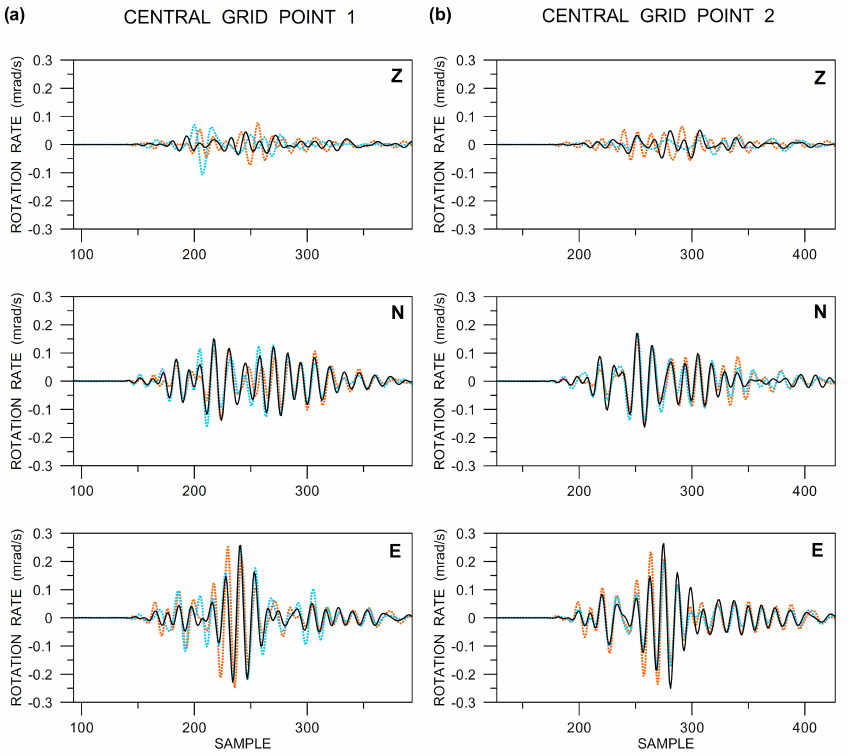
Figure 16. Comparison of the ADR (dotted orange), Rotaphone (solid black), and R-1 rotation rate components (vertical Z, North N, and East E) at the central grid points 1 ( a ) and 2 ( b ). The data are band-pass filtered between 6 and 20 Hz and instrument-corrected. The sampling frequency was 250 Hz. The Rotaphone and ADR amplitudes are real. The amplitudes of the R-1 records are multiplied by the following normalizing factors: 10 (Z), 5 (N), 2 (E) in part ( a ), and 1 (Z), 1.8 (N), 1 (E) in part ( b